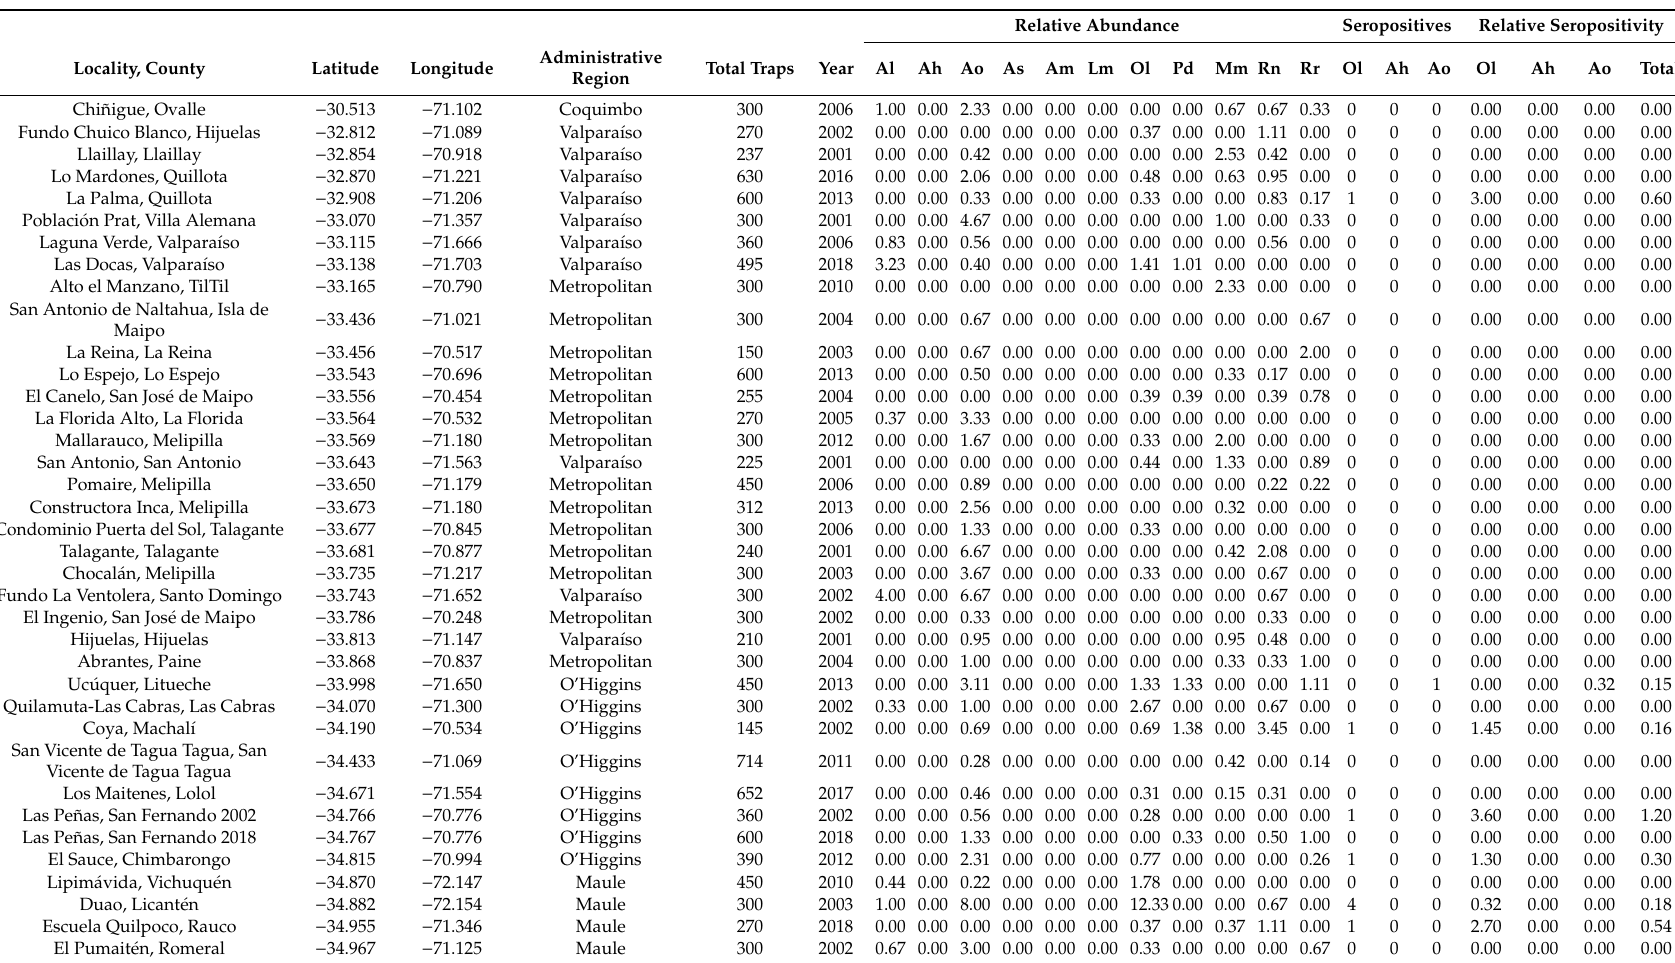
Table A1. Relative abundance, relative seropositivity and seropositives to ANDV by locality and administrative regions of rodent sampled species.